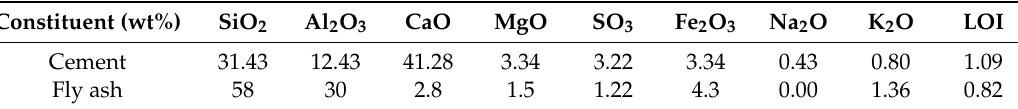
Table 1. Chemical composition of cement and fly ash.